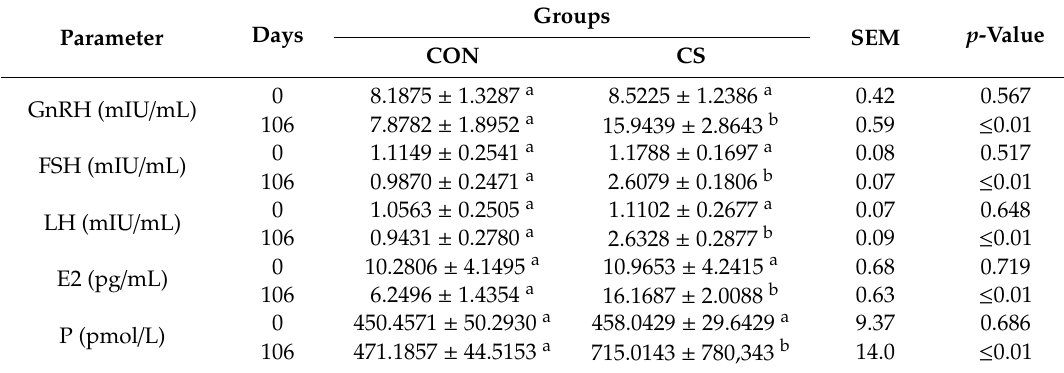
Table 5. E ff ect of cold season supplementation on serum reproductive hormone of the yaks.